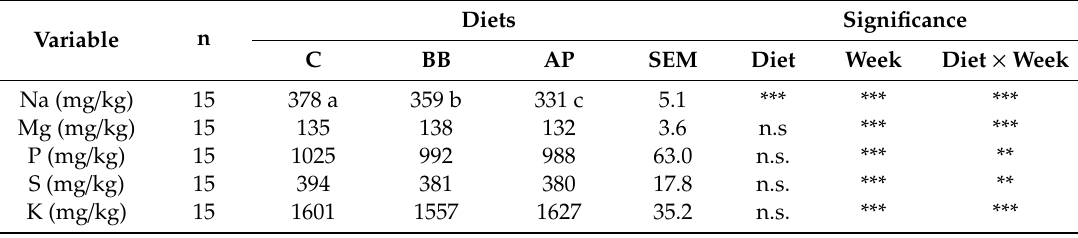
Table 4. Comparison of mineral profile from refrigerated goat milk tank according to the e ff ects considered from 7th to 27th lactation